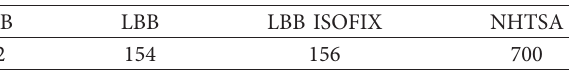
Figure 5: Head resultant acceleration. Table 1: HIC15.